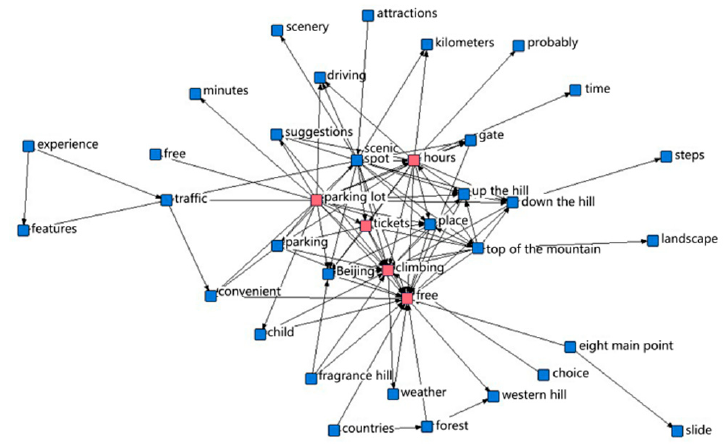
Figure 13. The semantic network of males’ evaluations.